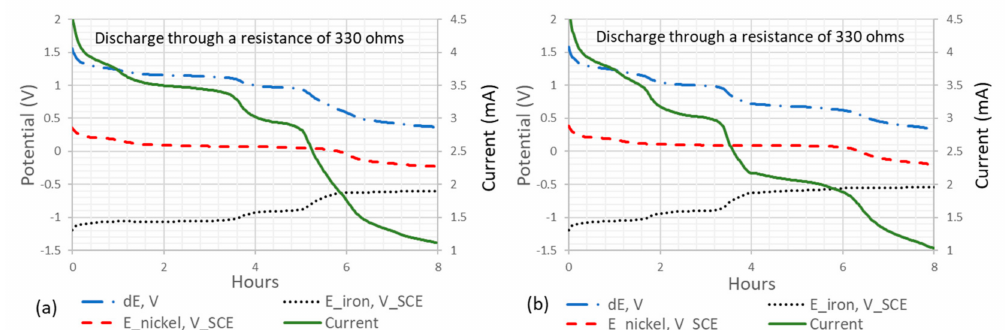
Figure 7. Potential and current profiles of the metal-coating Ni-CF cement-based anode against a pure iron plate cathode over two 8-h discharge cycles. Measurements include the potential difference between the anode and cathode (dE), the potential of the iron plate as the cathode (E_iron, V_ SCE ), the potential of the Ni-CF anode (E_nickel, V_ SCE ), and the current with a 330 Ω resistor. Subfigure ( a ) represents discharge cycle one and ( b ) discharge cycle two.